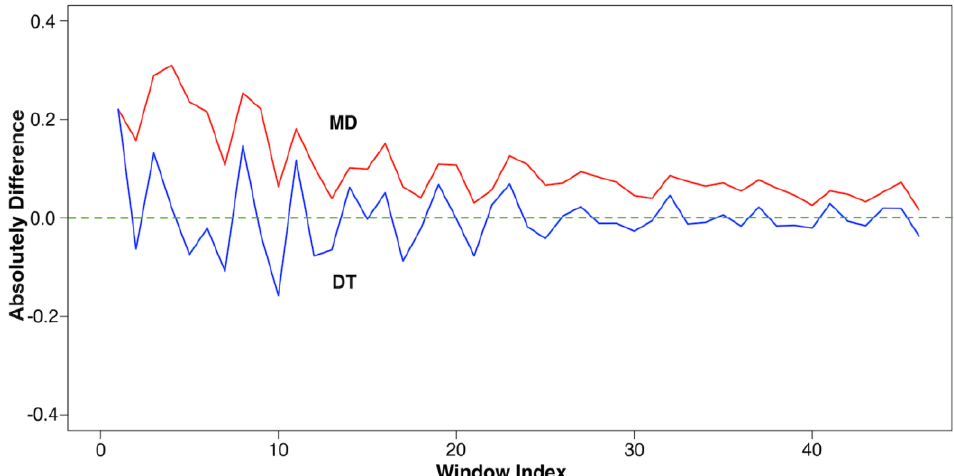
Figure 10. Trajectories of the MD and DT.